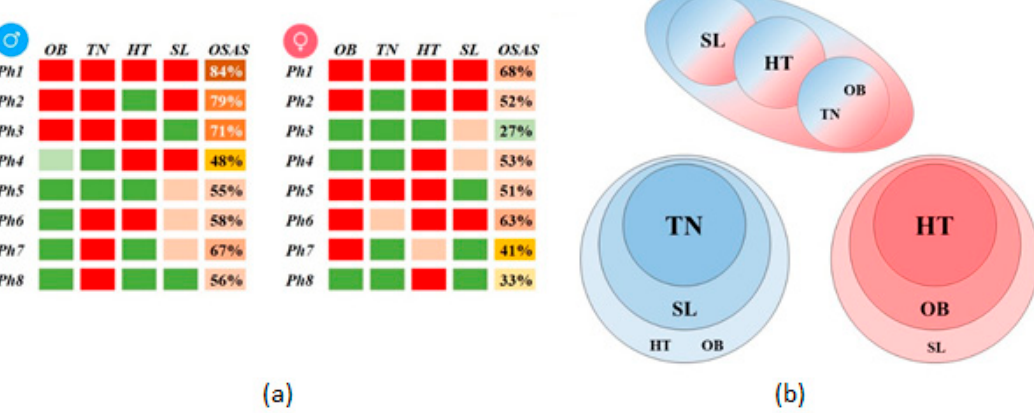
Figure 3. Gender phenotypes comparison: ( a ) Male and female phenotypes described by the four main parameter classes (red–sick, above-high threshold; pink–moderately sick, above-normal threshold; green–healthy, below-normal threshold), and OSAS prevalence (as a percentage); ( b ) Association of parameter classes for the two genders (males–blue, females–red); the upper panel represents overlapping phenotypes, while the lower panel represents gender-specific phenotypes.